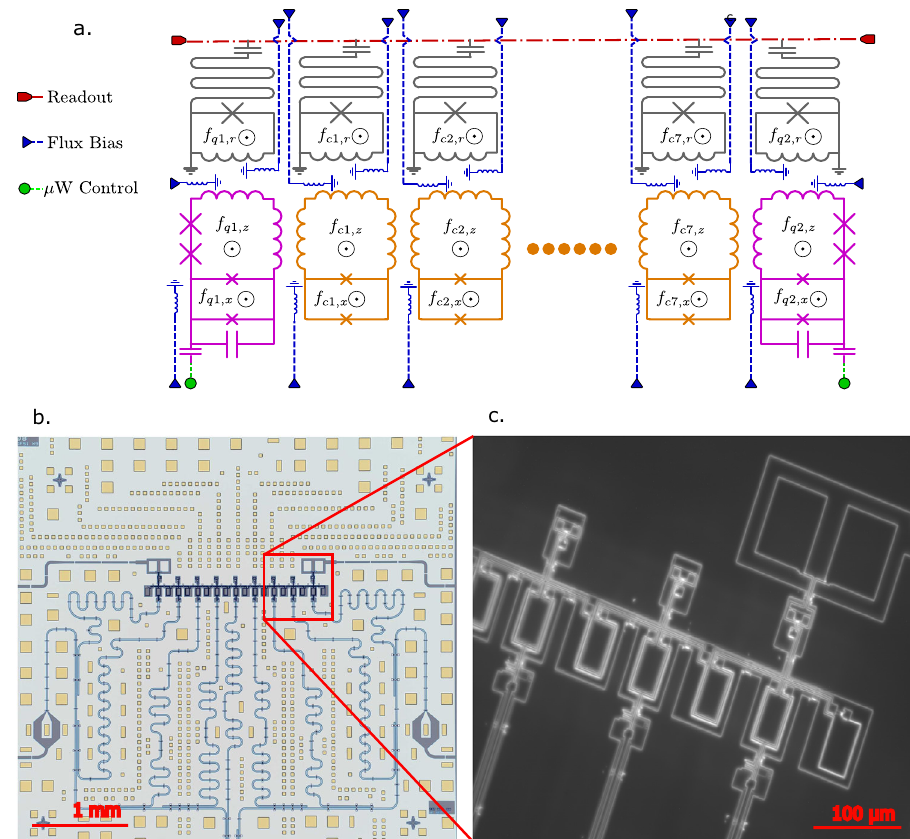
Fig. 1 Description of the Device. a A schematic showing the full device and circuit geometry: two end qubits, shown in magenta, and seven coupler units, shown in orange, each equipped with individual readout resonators. Also indicated are the fl ux control lines for the qubits, couplers, and readout resonators as well as the microwave control lines for the qubits and the microwave feed-through line for state readout. b , c Optical images of the device chip and an expanded view of one end of the coupler chain. The end qubit, capacitively coupled qubit microwave control line, the two adjacent coupler units, and respective readout structures are shown expanded in c . The readout rf-SQUIDs, connecting to both the qubit and coupler units, terminate at the end of their meandering resonators. The fl ux control lines are located on the opposing interposer